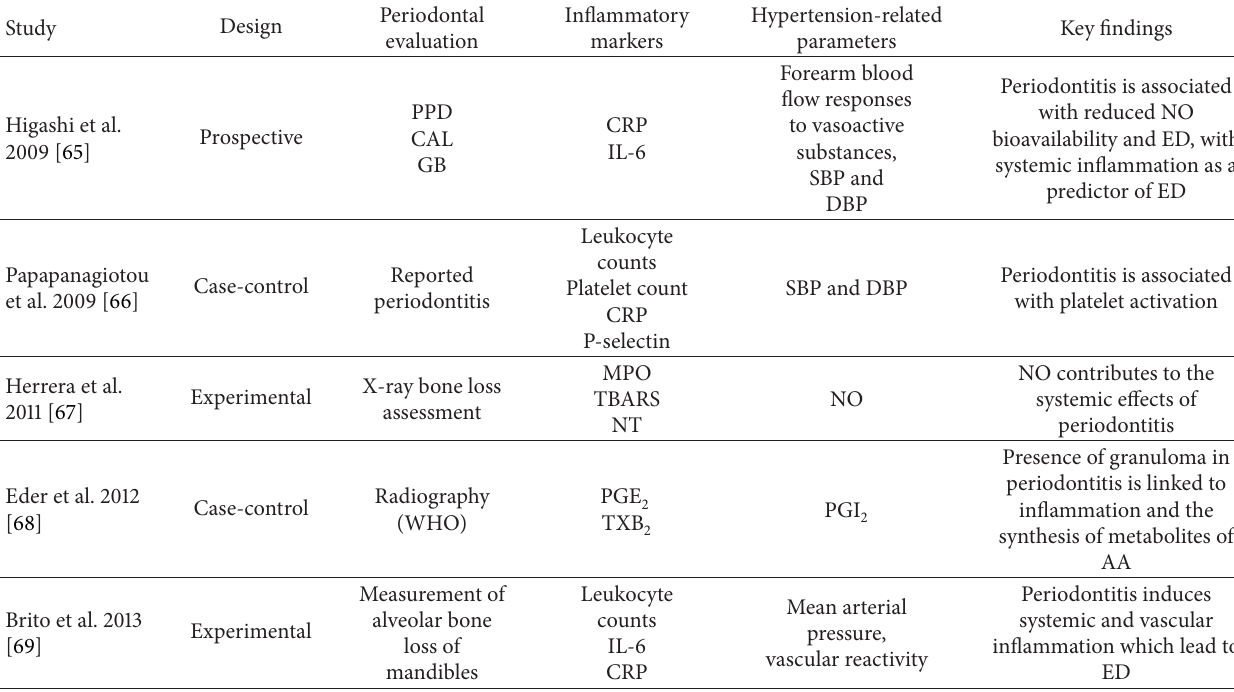
Table 2: Studies reporting inflammatory involvement in the interrelationship between hypertension and periodontitis. Study Key findings